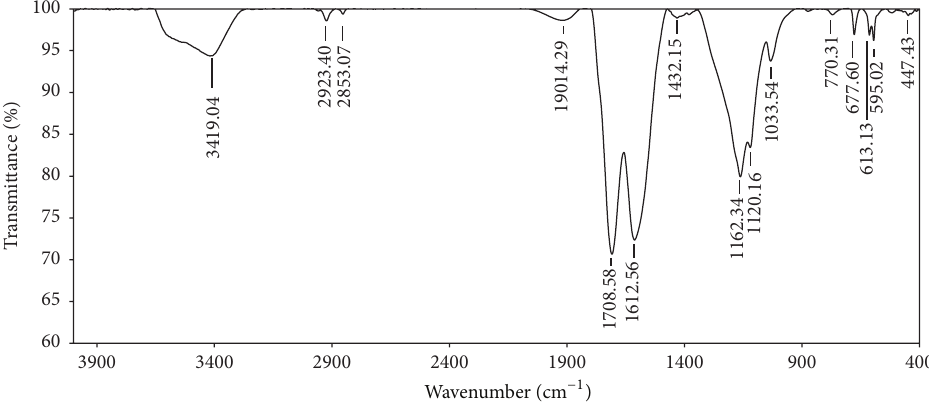
Figure 1: FTIR spectra of CCRWSD.